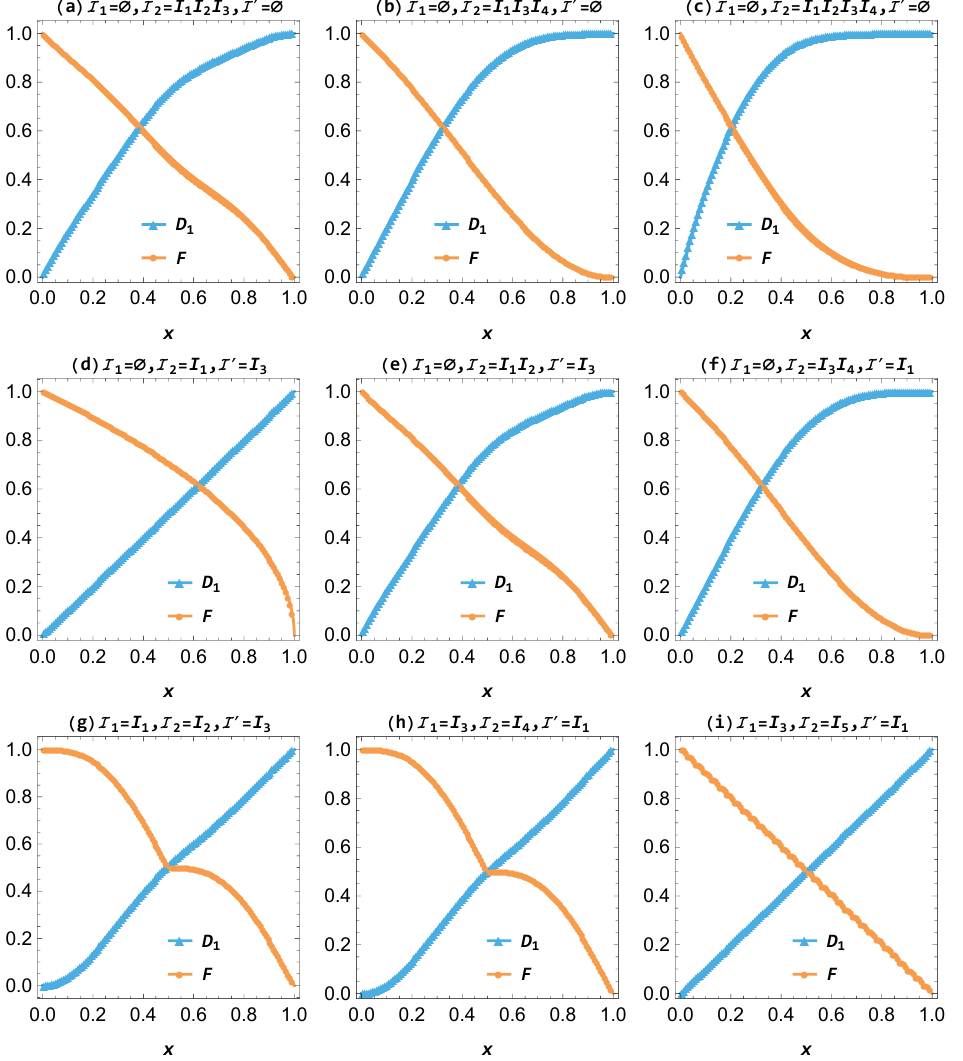
Figure 9 . Checks of the first conjecture (7.61) and (7.62) (the first row), the second conjecture (7.67) and (7.68) (the second row), and the third conjecture (7.70) and (7.71) (the third row) in the ferromagnetic phase of the spin-1/2 XXX chain. The symbols in each panel are numerical results for the trace distance D ( ρ ) and fidelity F ≡ F XXX ( ρ ) , XXX 1 ≡ D A,K 1 ∪ K 0 , ρ A,K 2 ∪ K 0 A,K 1 ∪ K 0 , ρ A,K 2 ∪ K 0 1 which are from the local mode method. The solid lines are the analytical conjectured results from the subsystem mode method in the free fermionic and bosonic chains. We have used the Bethe numbers of the excited magnons to denote the states. We have set the Bethe numbers ( I ) = (1 , 3 , L + 2 , L ) . For the analytical results we have set L = + ∞ , and for , L 1 , I 2 , I 3 , I 4 , I 5 4 4 2 numerical results we have set L = 128